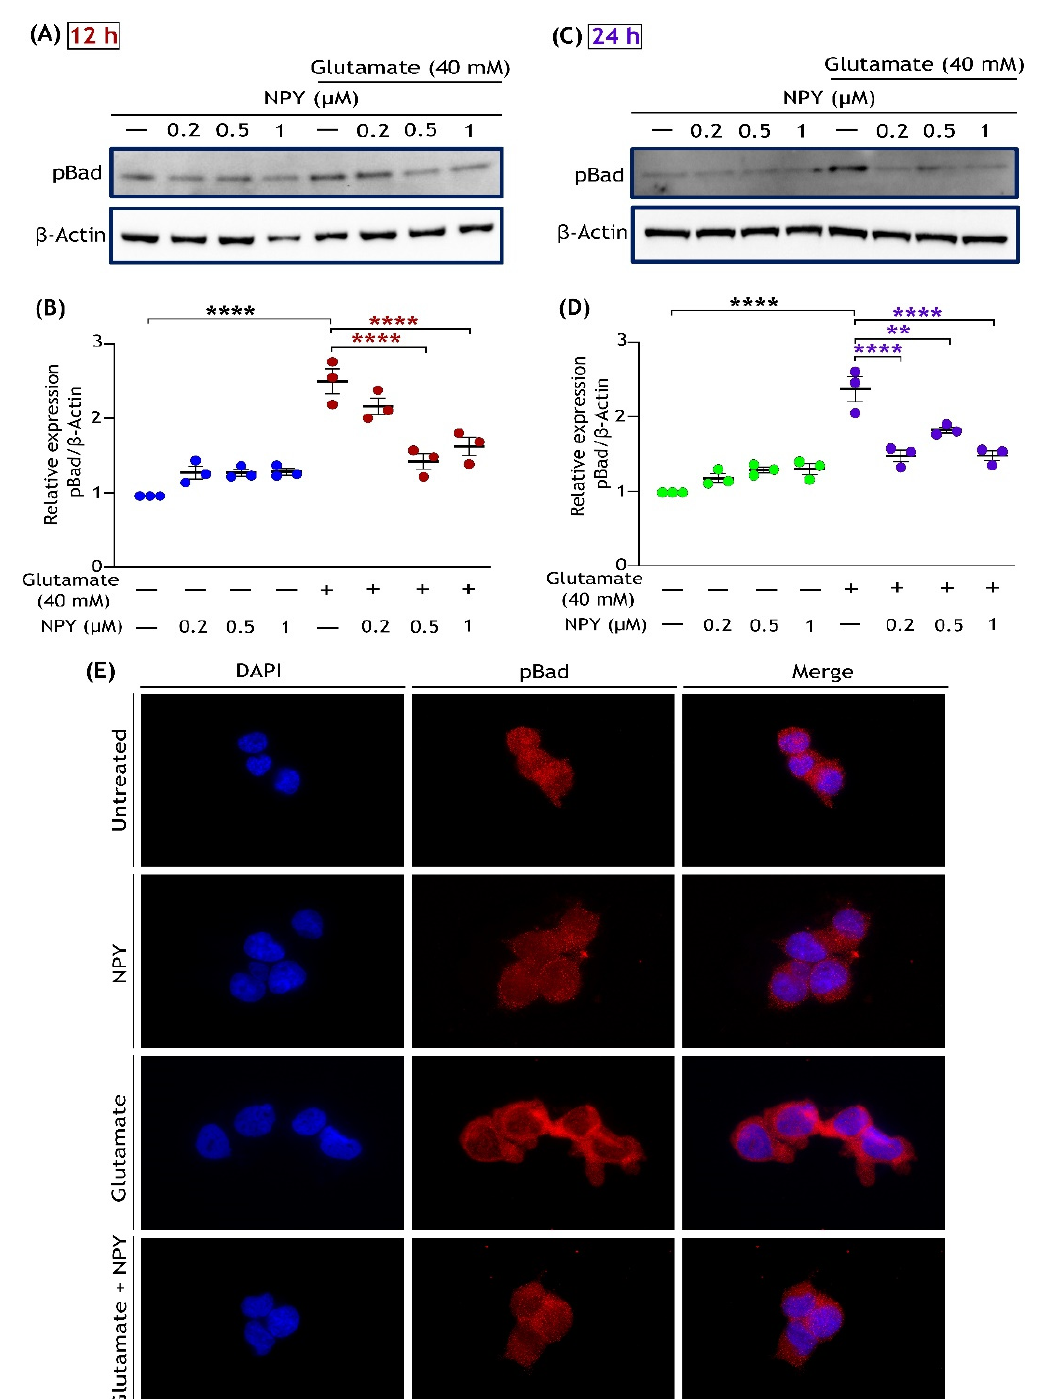
Figure 4. NPY treatment inhibits pro-apoptotic BAD phosphorylation caused by glutamate in SH- SY5Y cell cultures. Western immunoblot analysis for phosphorylation of BAD at Ser 128 under glutamate and NPY treatments (glutamate + NPY) at 12 h ( A ) and the densitometric quantification of phospho-BAD ( B ) reveals a significant increase in BAD activation under glutamate stress compared to control (F(1,16) = 108.1, **** p < 0.0001, n = 3) and a decrease with NPY treatment at 12 h (F(3,16) =